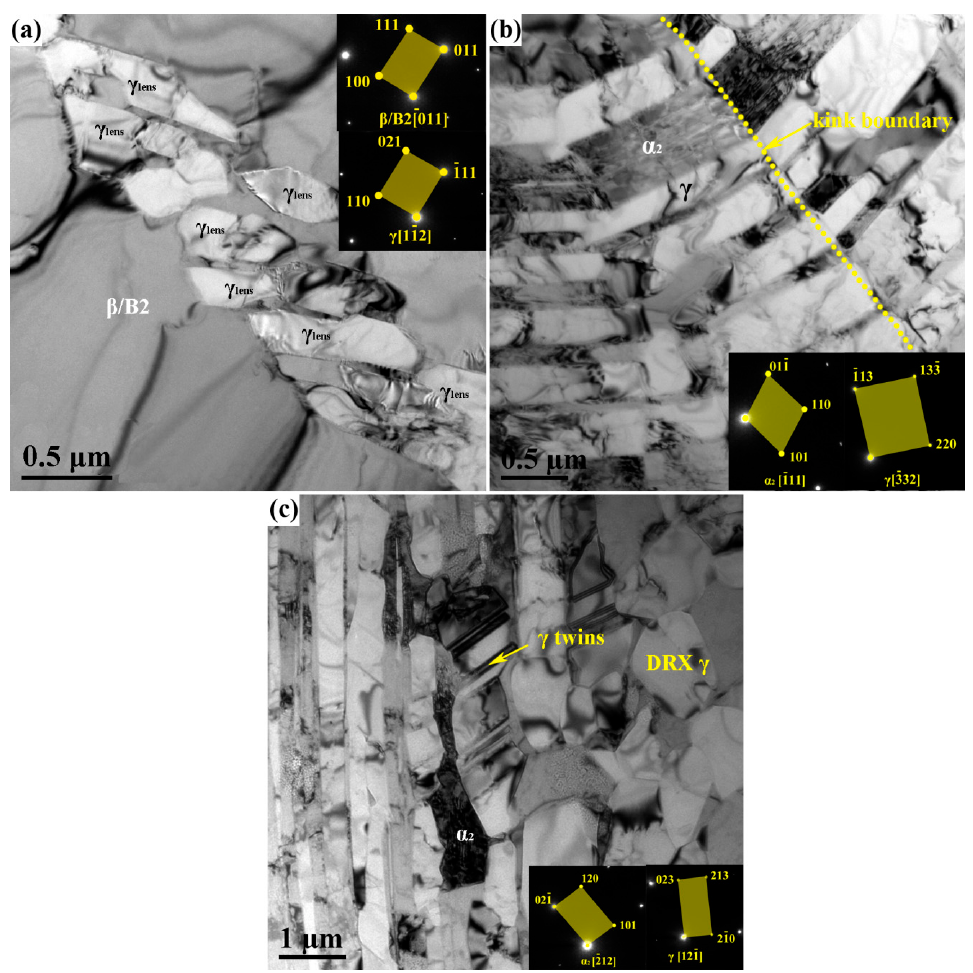
Figure 9. Bright-field TEM images showing the microstructures after 40% reduction: ( a ) γ lens precipitated in β /B2 phase; ( b ) kink band in α 2 / γ lamella; and ( c ) γ twins and DRX γ grains corresponding SAED patterns are shown in the corner.